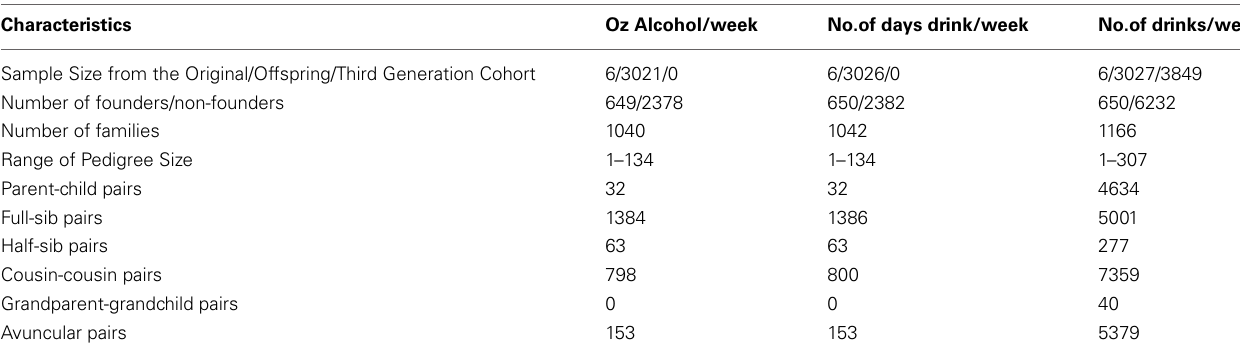
Table 2 | Pedigree information for each analysis